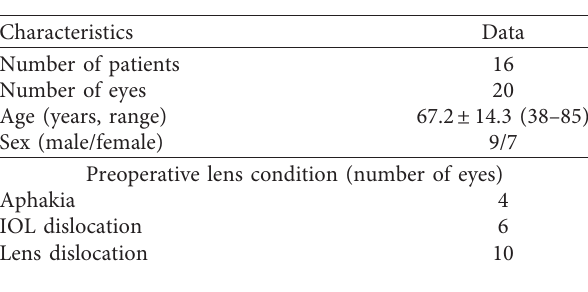
Figure 2: (a) Two-thirds superior conjunctival opening between 4 o’clock and 8 o’clock positions. (b) Half-depth radial scleral groove; (c) half-depth scleral flap; and (d) sclerotomy under each scleral flap using a 20G microblade; (e, f) bent 27G blunted needles (g, h) extruding haptics extraocularly; (i) locking of the trailing haptic with a small silicone piece; (j) burying the haptic into the scleral tunnel using a bent 30G ultrathin needle or (k) flanged haptic in case of a risk of dislocation. (l) A slit-lamp photo of the anterior segment of the eye after the operation. Table 1: Patient